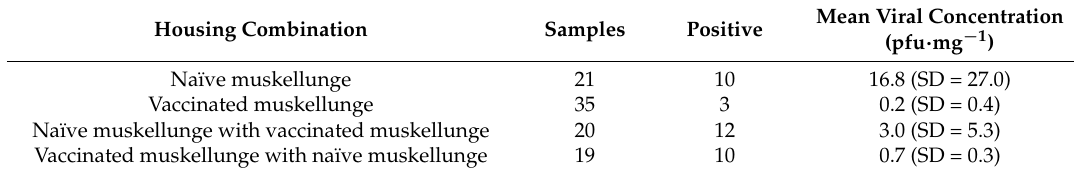
Table 5. VHSV-IVb concentrations in survivor tissues. Number of positive detections and mean viable VHSV-IVb concentrations in the posterior kidney of surviving muskellunge from cohabitation Trials 4,